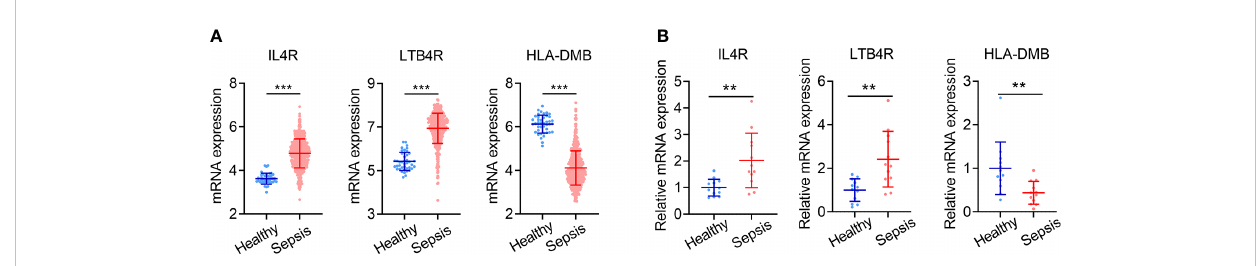
FIGURE 8 Validation of IRG signature genes in clinical specimens. (A) Expression levels of IL4R , LTB4R and HLA-DMB in sepsis patients (n = 479) and healthy controls (n = 42) in GSE65682. (B) Expression levels of IL4R , LTB4R and HLA-DMB analyzed by qPCR in 24 cases of clinical specimens (12 sepsis patients and 12 healthy controls). Data is shown as mean ± SD. **P < 0.01, ***P <